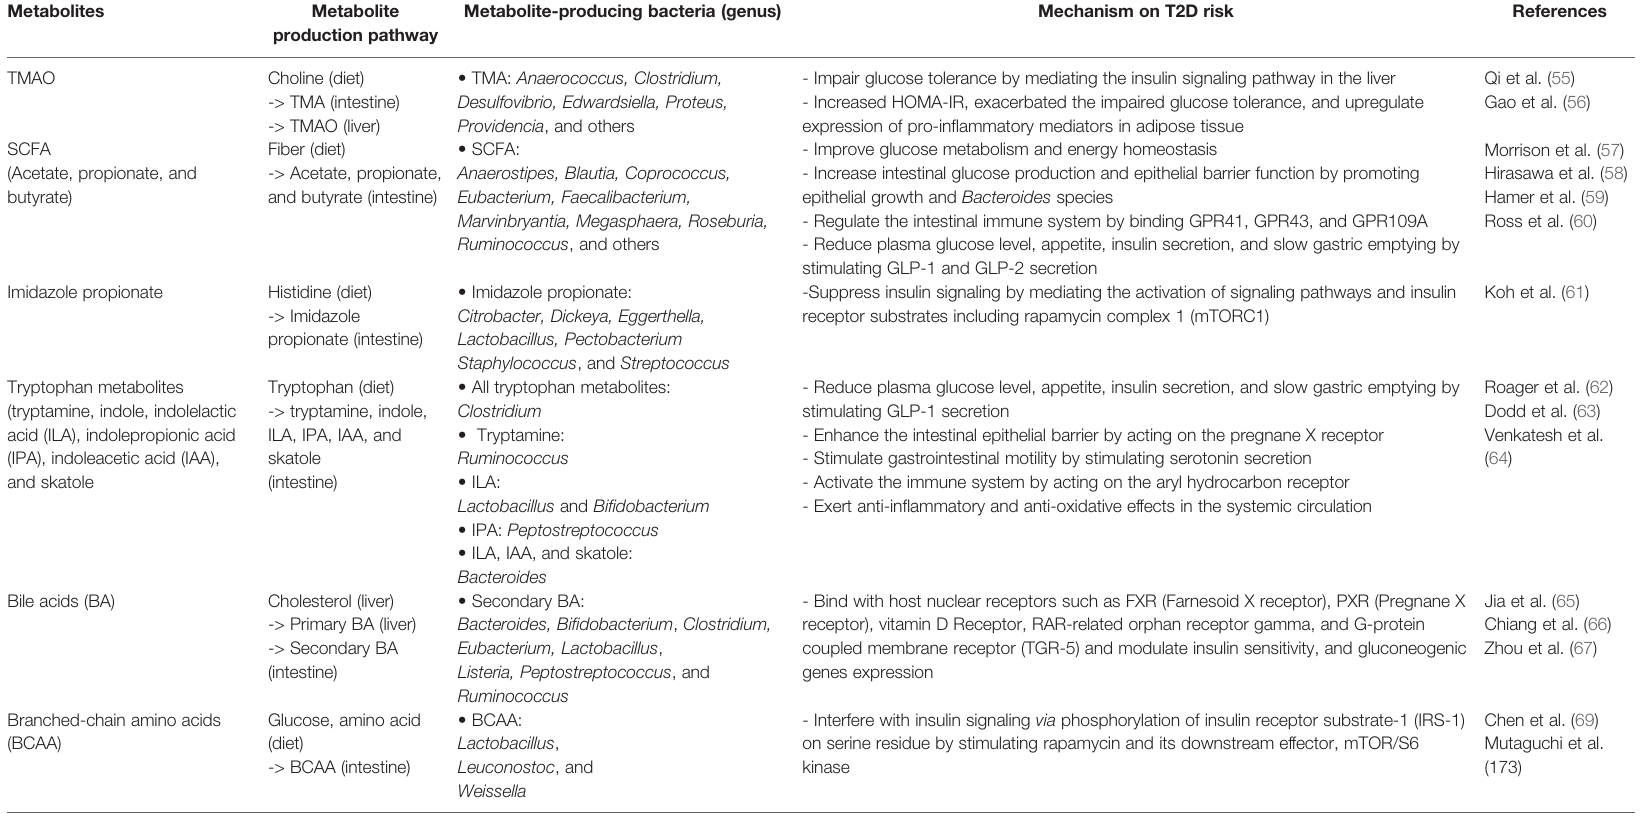
TABLE 2 | Role of microbial metabolites on